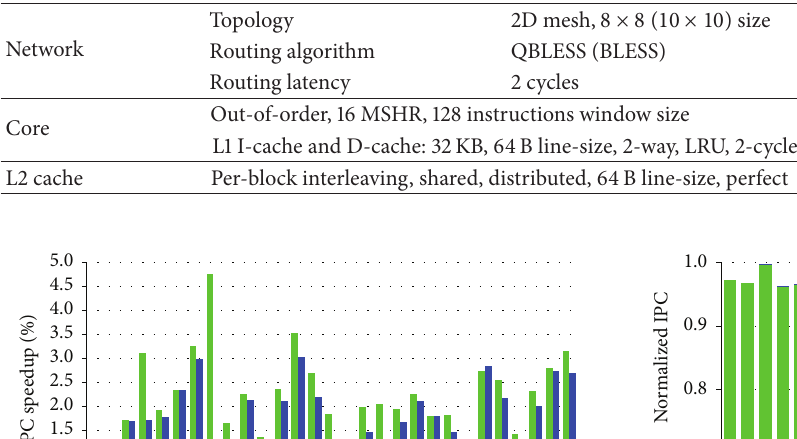
Figure 6: Performance of high-priority applications. Table 2: System parameters for evaluation.